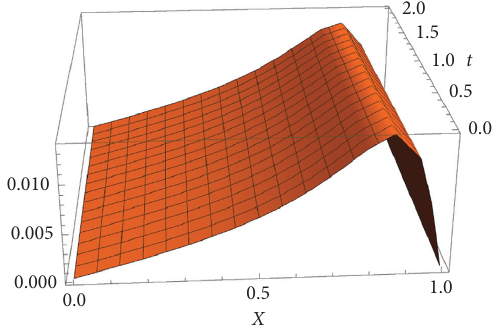
Figure 6: The 3-dimensional plot for the computed solution when a � 1 . 1 , μ � 0 . 001 , and N � 32 for Example 2.